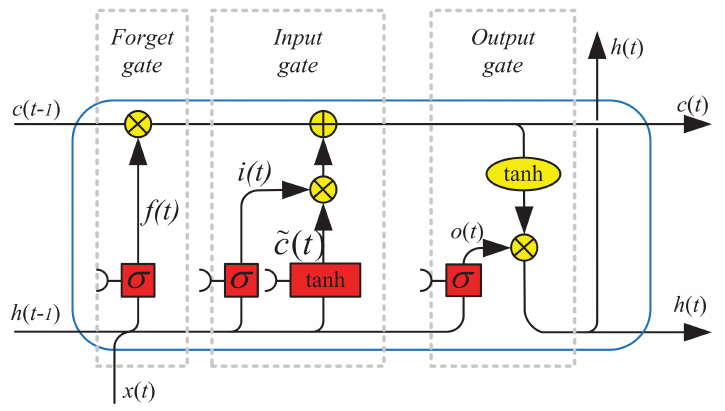
Figure 2. Architecture of LSTM with a forget gate. Reproduced from